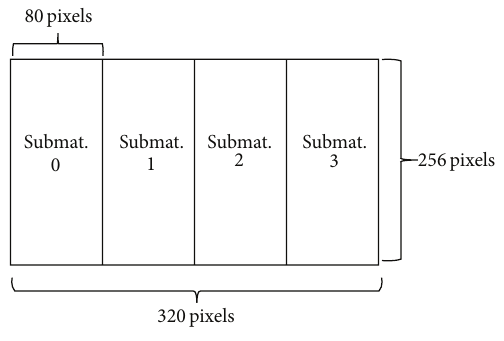
Figure 21: Matrix